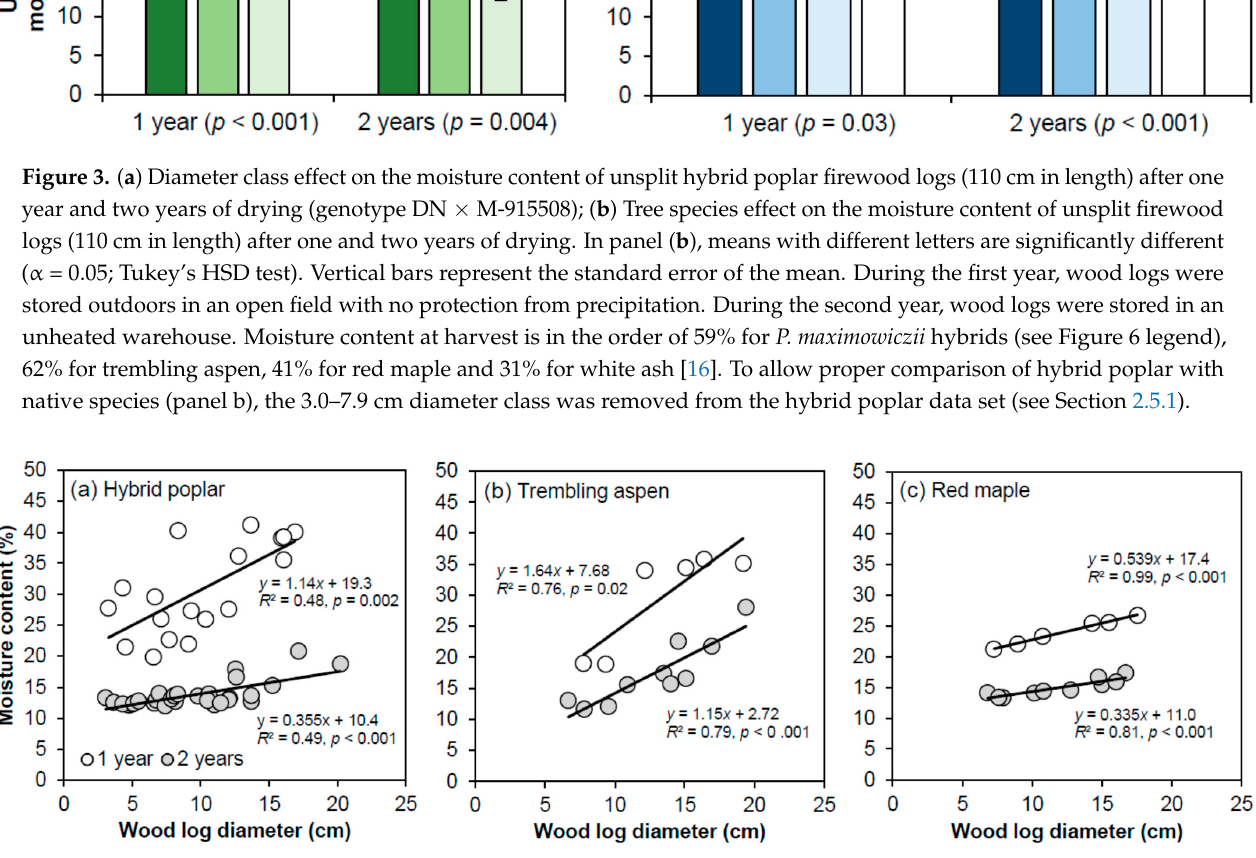
Figure 4. Linear relationships between the diameter of unsplit firewood logs (110 cm of length) and their moisture content after one year and two years of drying for: ( a ) hybrid poplar (genotype DN × M-915508); ( b ) trembling aspen; and ( c ) red maple. No significant relationship was found for white ash. For the one- and two-year relationships, respectively, n = 18 and n = 30 for poplar, and n = 6 and n = 10 for aspen and maple.